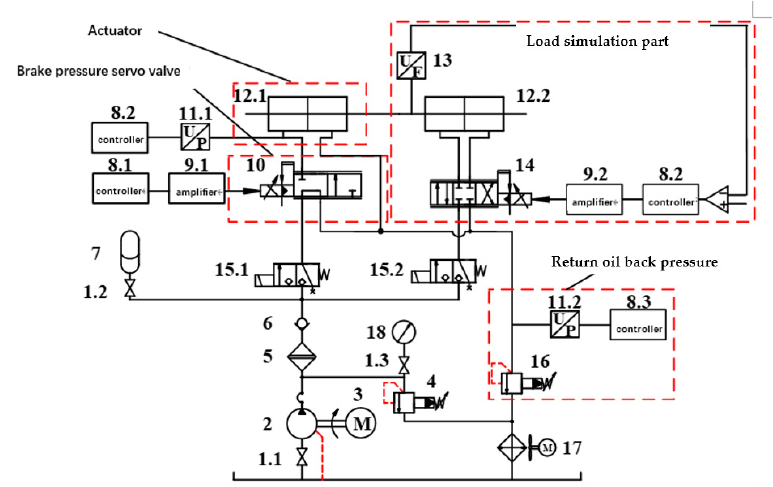
Figure 17. The hydraulic principle of ABPSVCS experiment platform.